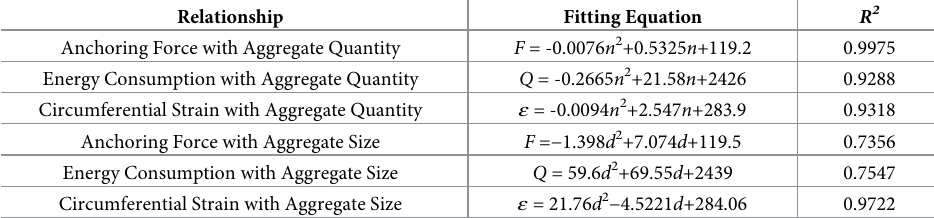
Table 4. Relationships of the anchoring force, energy consumption, and circumferential strain with aggregate quantity and size.